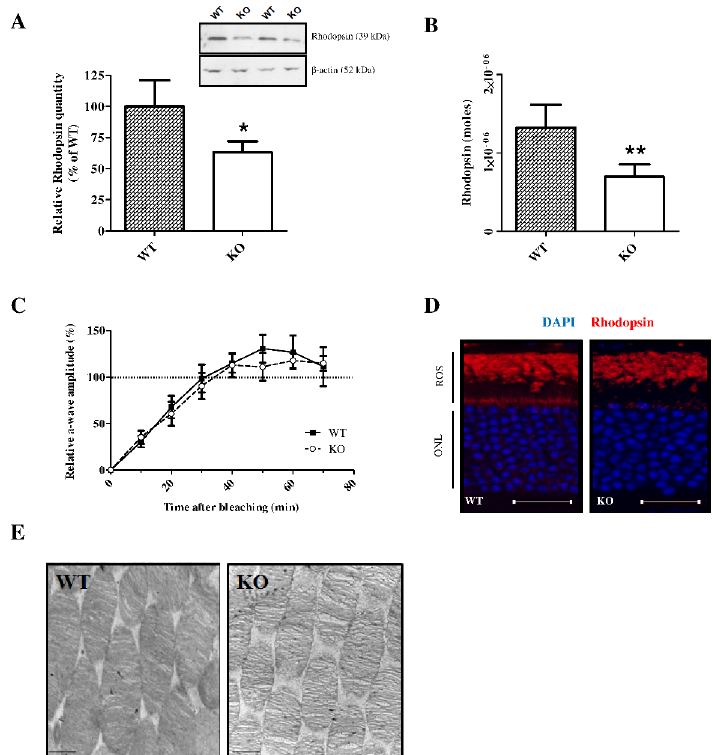
Figure 5. Rhodopsin characterization in adult WT and Fmr1 KO mice retinas. ( A ) Rhodopsin protein amount was assessed by Western-blot analysis (n=12 per group). All protein variations were normalized to b -actin. Rhodopsin protein was decreased by 37% (*p , 0.05) in Fmr1 KO mice compared to WT retinas. Three independent experiments were performed with similar results. ( B ) Rhodopsin protein decrease is confirmed by spectrophotometric quantification (n=6 per group). Indeed, Rhodopsin amount was decreased by 47% (**p , 0.01) in Fmr1 KO mice compared to WT retinas. ( C ) Rhodopsin isomerisation was investigated by studing a-wave recovering following 2 minutes bleach (n=5 per group). Forty minutes after bleaching the relative a-wave amplitude was returned to dark-adapted value. No difference was observed between WT and Fmr1 KO retinas. ( D ) Localization of Rhodopsin was done by immunostaining. Immunohistochemistry analysis demonstrated that Rhodopsin is distributed in ROS and between nucleus in the ONL in WT mice, whereas in Fmr1 KO mice only the ROS labelling could be observed (n=4 per group). Scale bar, 40 m m. ( E ) ROS ultrastructure was investigate by Transmission Electron Microscopy in adult WT and Fmr1 KO mice retinas. The images were set at 16000X magnification, with scale bars indicating 50 nm. These representatives pictures showed that density and linear organization of disks in Fmr1 KO mice ROS are altered compared to WT mice ROS. Data are presented as Mean 6 SEM. Student’s t test, *p , 0.05, **p , 0.01.